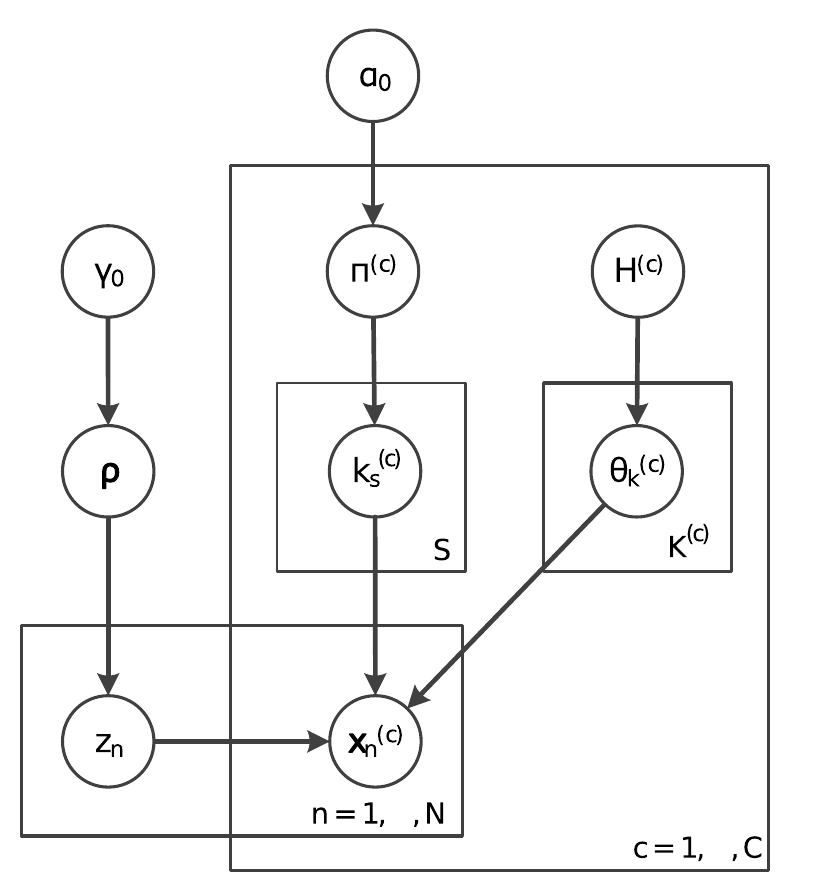
Fig 23. Graphical model representation of the decoupled context-dependent integrative clustering